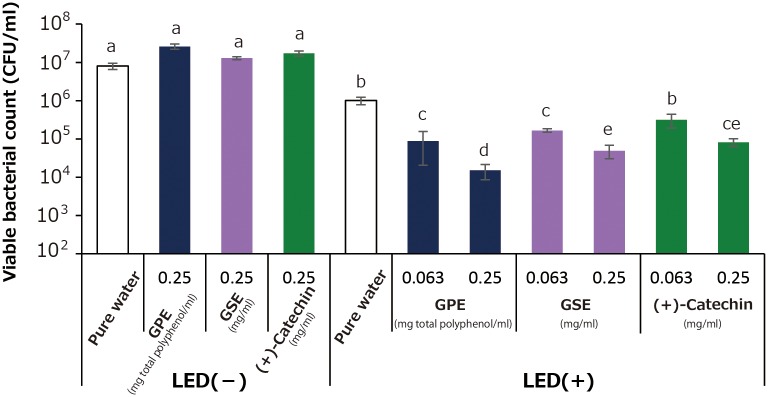
Bactericidal activity of photo-irradiated GPE, GSE, and (+)-catechin on Staphylococcus aureus.LED light was irradiated for 10 min. Each value represents the mean with standard deviation (n = 3). Significant differences (p<0.05) in each group are denoted by different alphabetical letters.